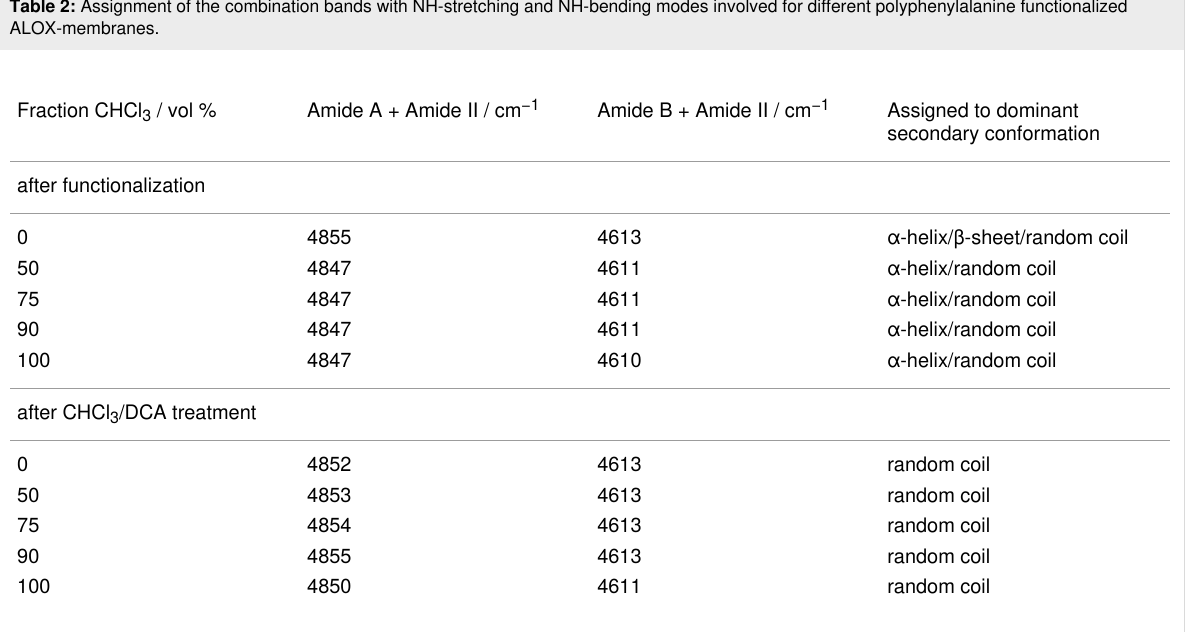
Table 2: Assignment of the combination bands with NH-stretching and NH-bending modes involved for different polyphenylalanine functionalized ALOX-membranes.